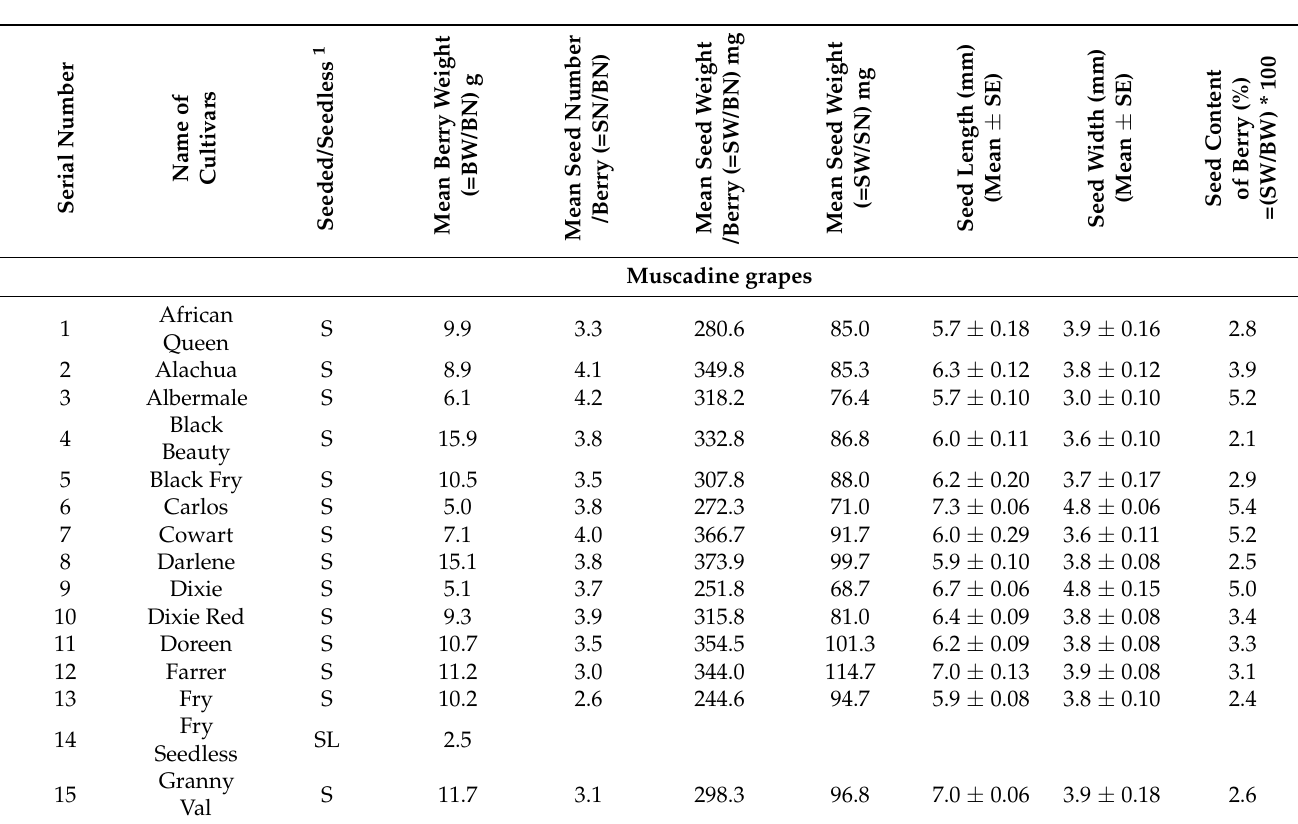
Table 1. Berry and seed characteristics of muscadine, hybrid bunch and bunch grape cultivars grown in vineyard at Center for Viticulture and Small Fruit